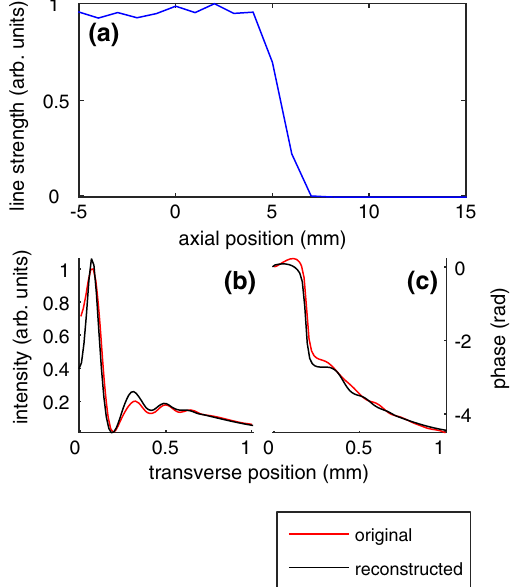
FIG. 8. (a) Line emission (in arbitrary units) of the neutral helium 3 3 D – 2 3 P, λ ¼ 587 . 6 nm transition induced by a tightly focused 800 nm pulse as a function of helium cell position. (b) Simulated filament intensity and (c) spatial phase at 800 nm (black) just before the ∼ 4 -mm air-helium transition, as well as reconstructed intensity and phase (red). The reconstruction is performed by propagating the solution 4 mm through the transition region followed by 50 cm of helium. The simulated pulse is then backpropagated through 50.4 cm of vacuum to simulate reconstruction from imaging